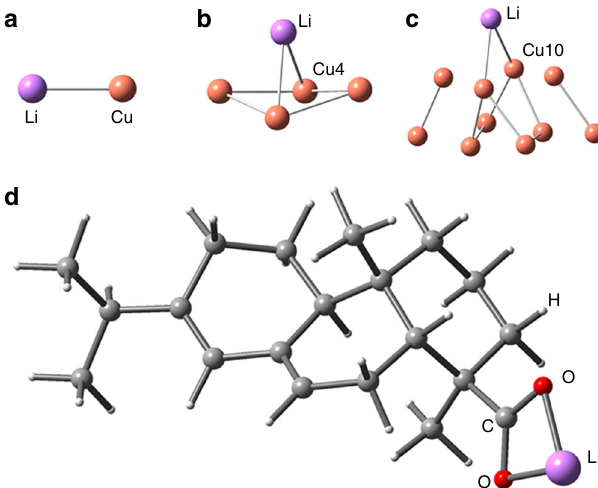
Fig. 5 Theoretical calculation of the newly formed ionic bonds based on chemisorption. a – c The newly formed ionic bond between Li and Cu clusters. d The newly formed ionic bond between Li and abietic acid